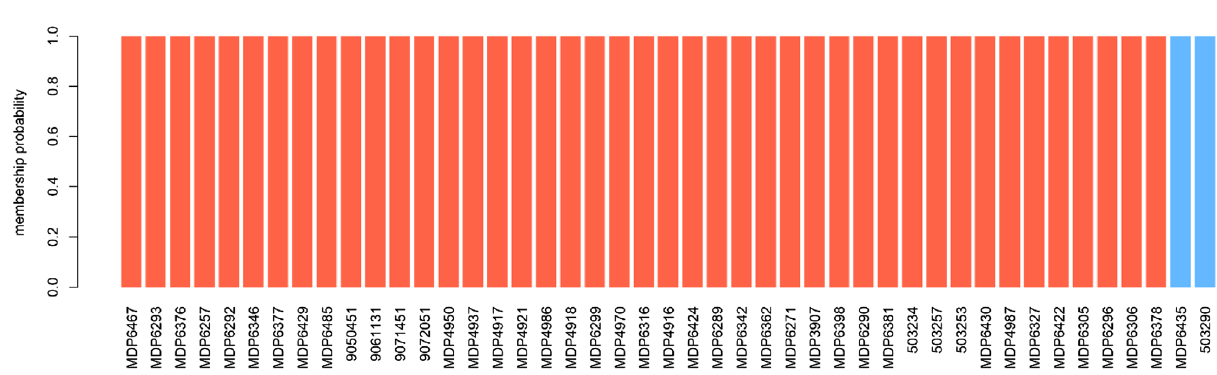
Figure 3. Phylogenetics results. ( a ) Median-joining network of Peruvian P. falciparum strains and control samples from South America (Honduras and Colombia). The network shows the distribution of lineages according to their barcode and the geographical clustering of P. falciparum lines. Each circle represents an independent haplotype, the lines connect nearby haplotypes and the cross line represents one non-synonymous mutation. Figure created in PopART 48 . ( b ) Maximum likelihood phylogenetic analysis of P. falciparum samples. Circles in tree nodes represent bootstrap support values, 3D7 denotes P. falciparum 3D7 strain. Figure generated in Figtree (http:// tree. bio. ed. ac. uk/ softw are/ figtr ee/).